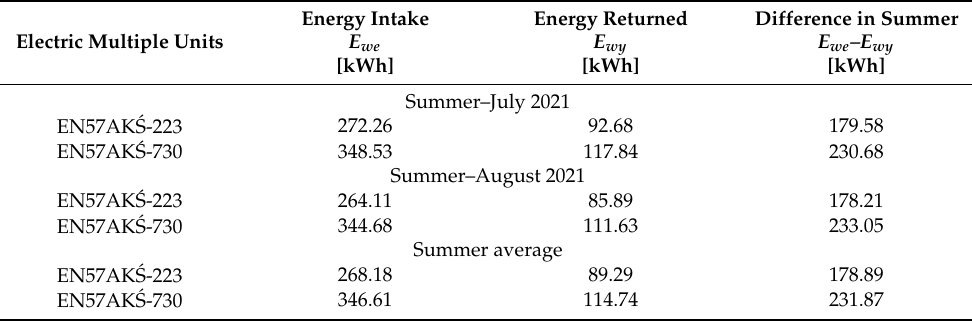
Table 7. Summary of energy intake and return during the summer period.